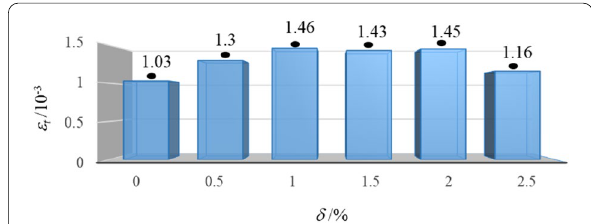
Fig. 18 Relationship between ɛ t and fiber volume fraction